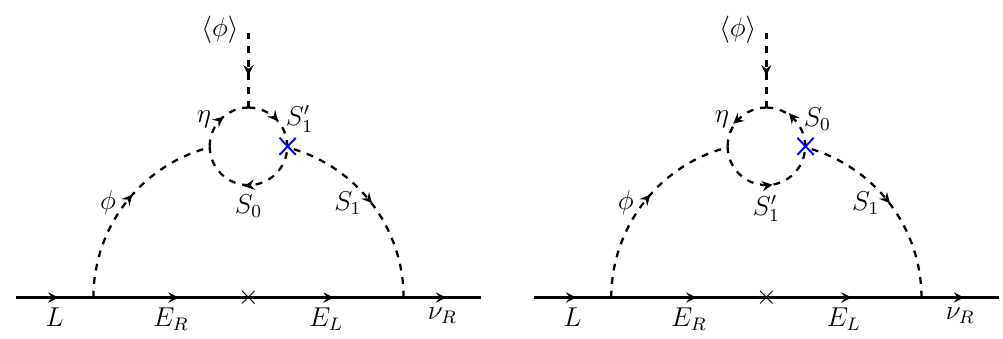
Figure 12 . Leading contributions to neutrino masses. The blue cross marks the soft breaking term of the symmetry that allows the two-loop realization of the operator L(cid:30) c (cid:23) R . Note that Z 2 the small scalar loop cannot be reduced into a tree-level